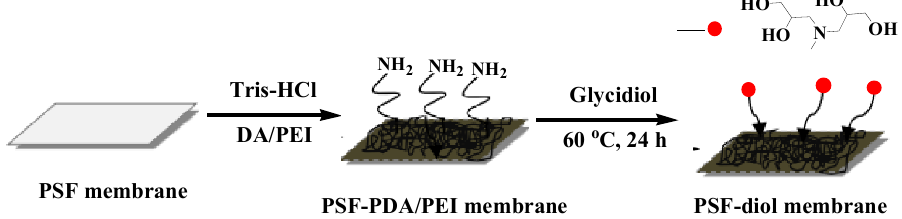
Figure1. Schematicillustrationforpreparingpolysulfone(PSF)compositemembranes. DA—dopamine; Figure 1. Schematic illustration for preparing polysulfone (PSF) composite membranes. PDA—polydopamine; DA—dopamine; PDA—polydopamine; PEI—polyethyleneimine.